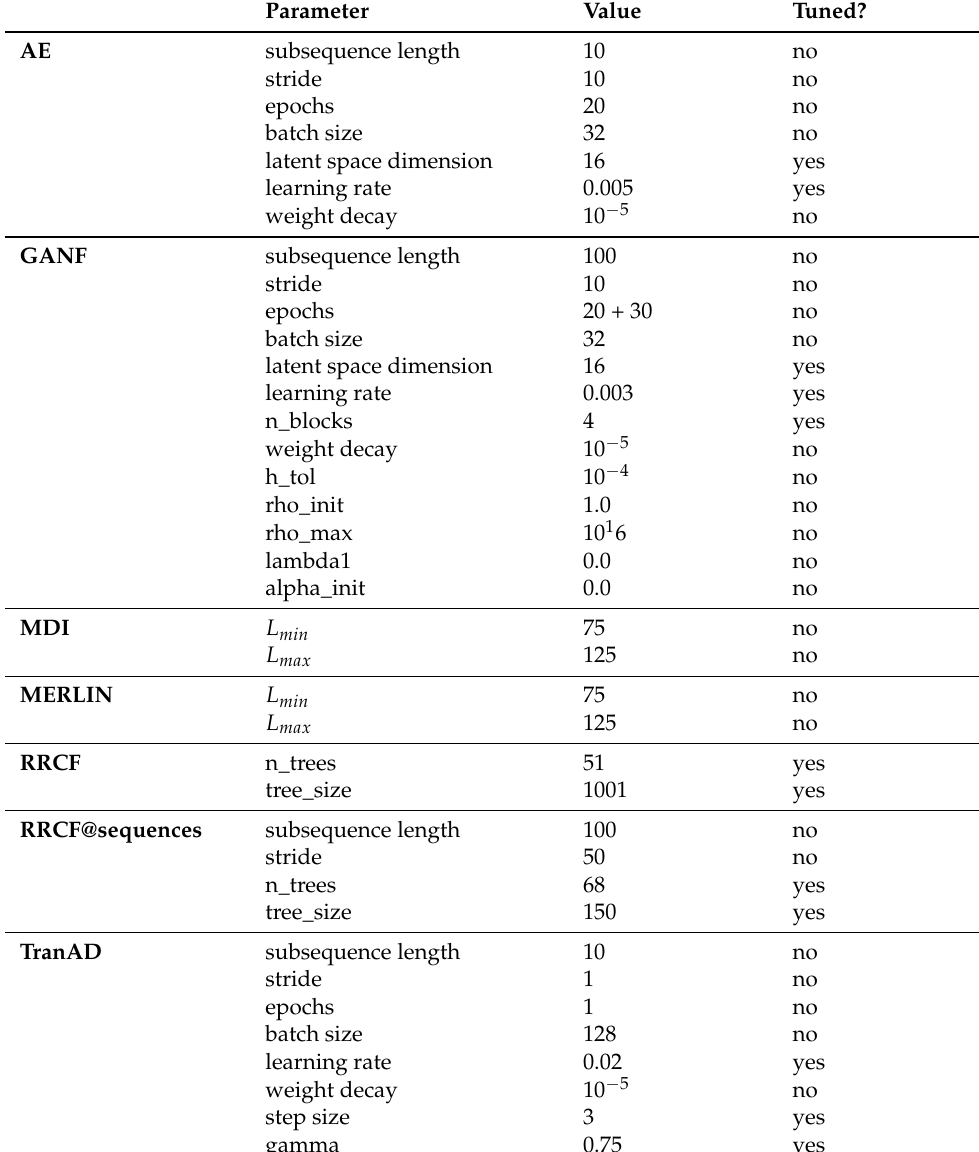
Table A2. Tuned and not tuned parameters used in our experiments. All other parameters within the methods have been kept to their default